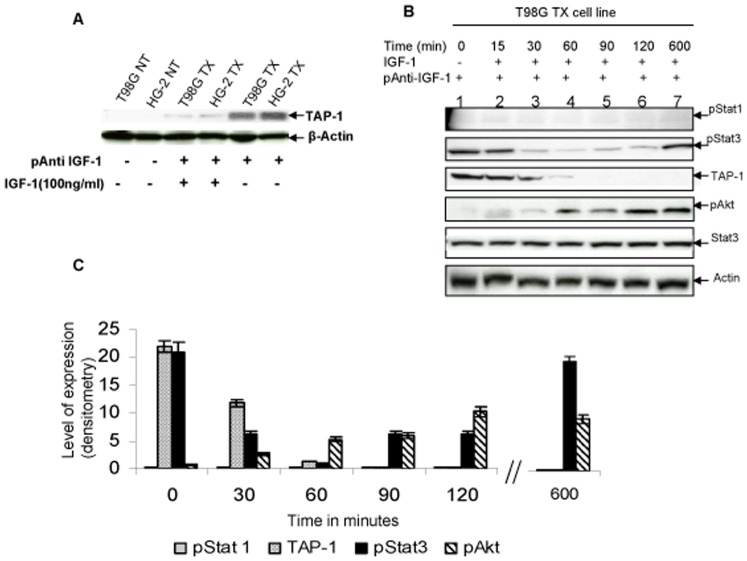
Effect of exogenous IGF-1 on expression of TAP-1, pStat1(Tyr701) and pStat3(Tyr705). A,Expression of TAP-1 peptide in T98G cells was down-regulated by addition of IGF-1 to culture medium. TX cells were incubated in absence of serum and in the presence of 50 μM ZnSO4 and IGF-1 (100 ng/ml) over-night. Lanes 1 and 2 are NT cells from the T98G and HG-2 cell lines respectively. Lane 3 and lane 4 are T98G TX (clone b) and HG-2 TX (clone 5), respectively, into which IGF-1 was added overnight. Lanes 5 and 6 are as in lanes 3 and 4 except without added IGF-1. B. The expression of TAP-1 was examined as a function of time following addition of IGF-1 (100 ng/ml) in TX T98G cells in absence of serum and in the presence of Zn2+. Cells were treated with exogenous IGF-1 for the time periods as depicted. The cell lysates were prepared and subjected to Western Blot analysis as described in methods. The primary antibodies to TAP-1, pStat1 (Tyr701), pStat3 (Tyr705) and Stat3 were also obtained as described. The 70 kd TAP-1, 91 kd pStat1, and 86 kd pStat3 and 86 kd Stat3 peptides produced during the time course were identified by monoclonal antibody used and molecular weights. The data represent one of three sets of similar experimental results. C, Data from
Fig 7

B and similar results from two repeat experiments were used for this bar graph. The densitometry quantification was done using the NIH image J program as described in methods.